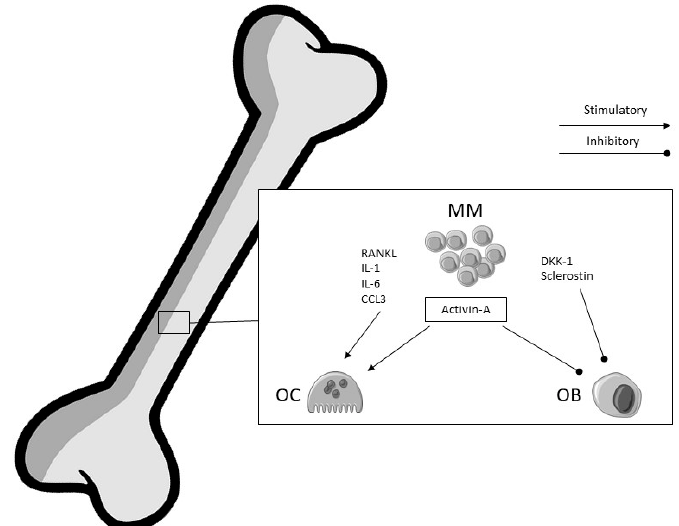
Figure 1. Simplified pathogenesis of osteoporosis in multiple myeloma. MM: multiple myeloma cells; OC: osteoclast; OB: osteoblast; RANKL: receptor activator of NF- κ B ligand; IL-1: interleukin-1; IL-6: interleukin-6; CCL3: chemokine C–C motif ligand 3; DKK-1: dickkopf-1.